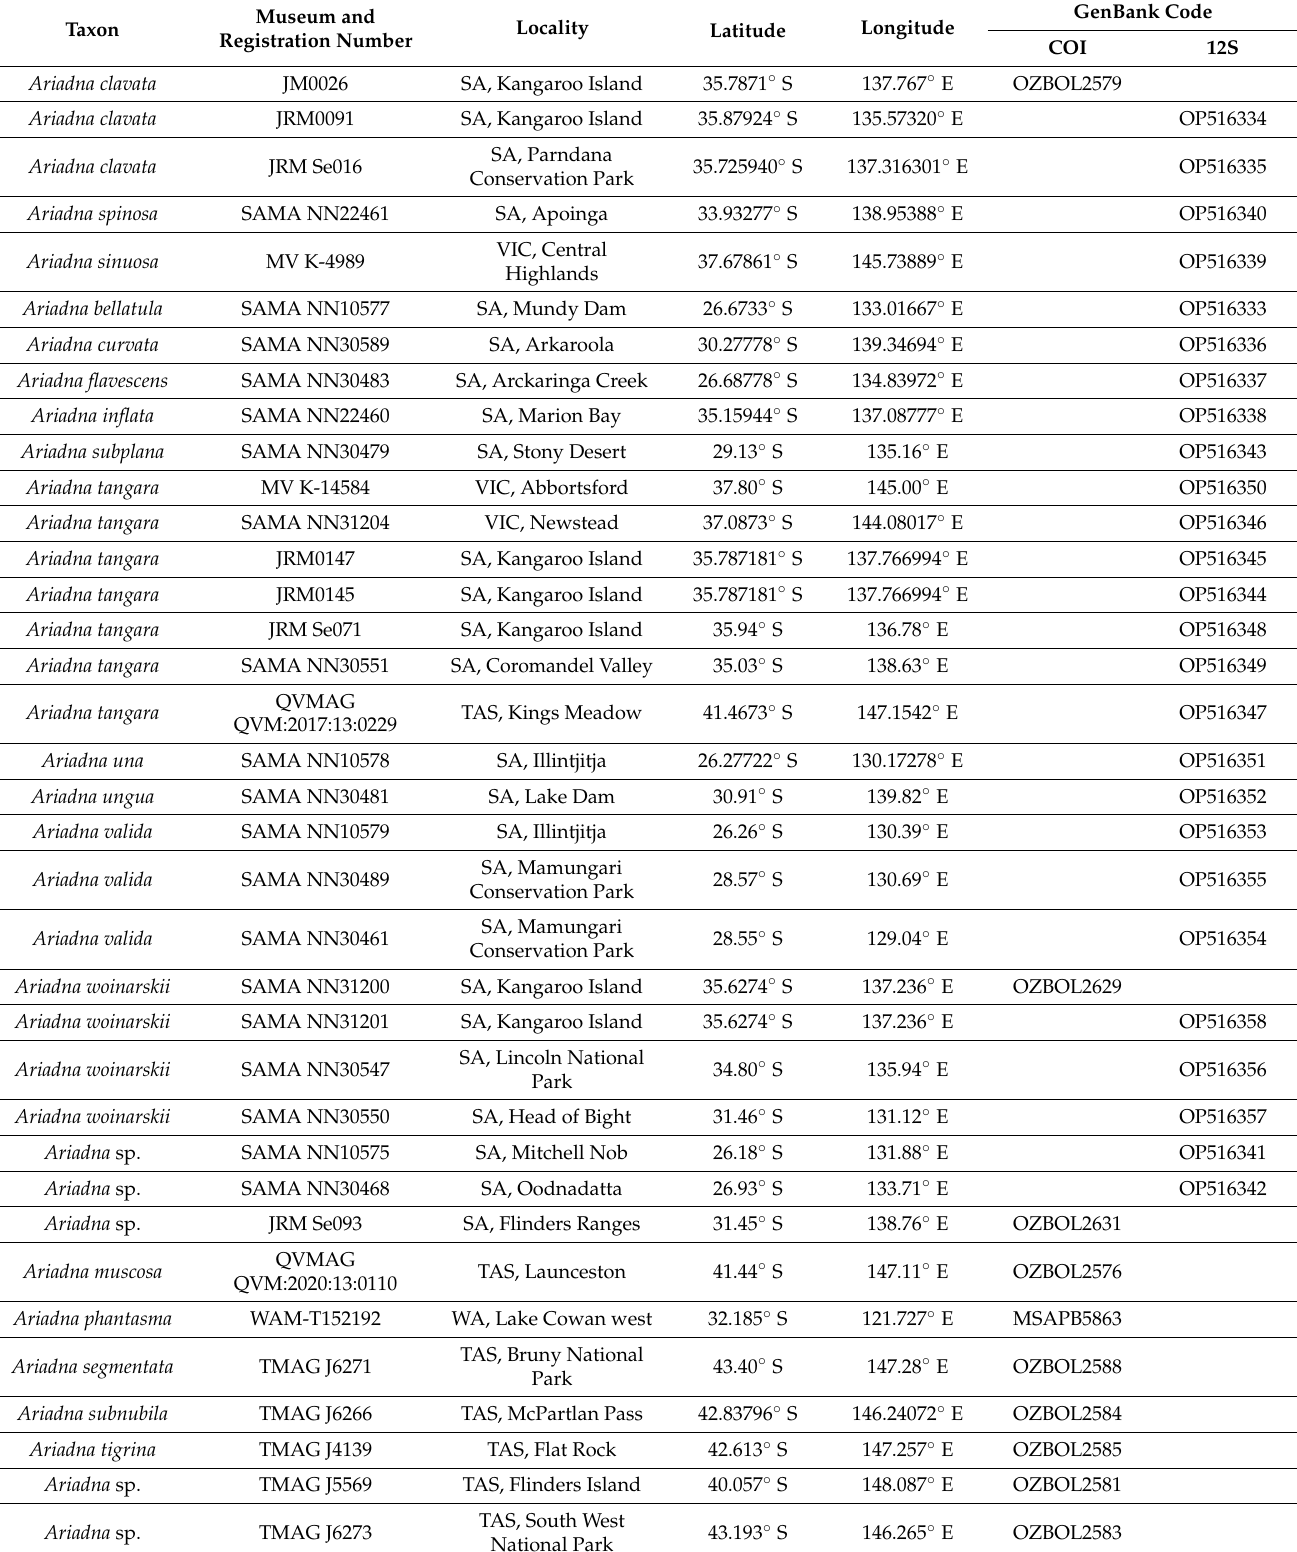
Table 1. Specimens sequenced in the current study, for all relevant and new species, with BOLD process IDs for COI and GenBank accession codes for 12S. Species treated in this study are presented in the order they appear in this